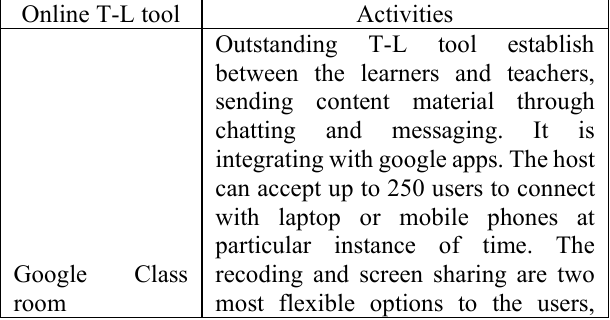
Table 1. Popular online T-L platforms